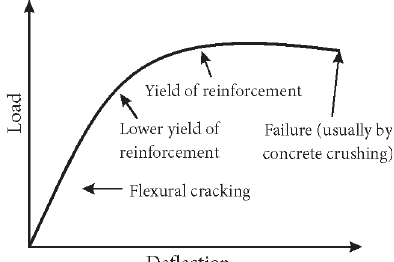
Fig. 1. Typical load deflection curve for under-reinforced beam (Bungey, Millard